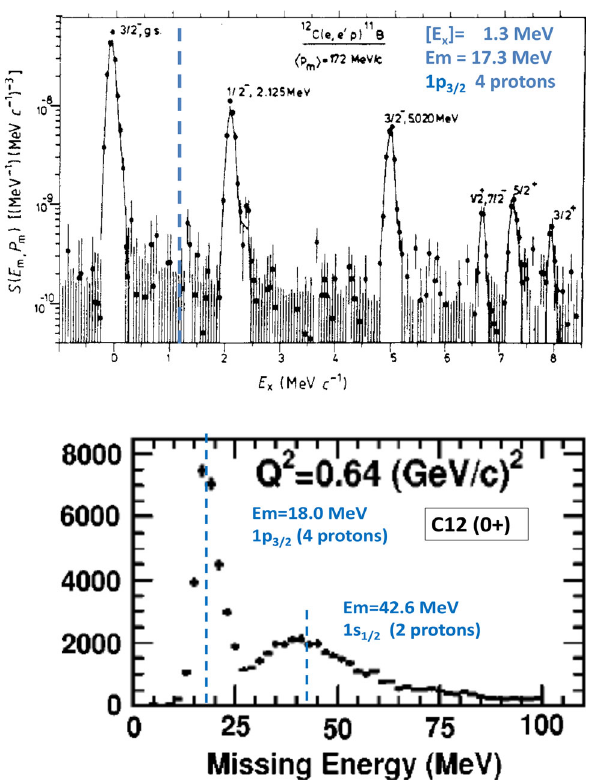
Fig. 5 Top panel: The measured [44,45] NIKHEF high resolution C as a function of spectral function for protons in the 1p level of 12 6 the spectator nucleus excitation energy E P x for p m = k = 172 MeV / c. Bottom panel: The Jlab measurement [37,38] of the one-dimensional C as a function of missing energy E P m for spectral function for 12 6 Q 2 = 0 . 64 GeV 2